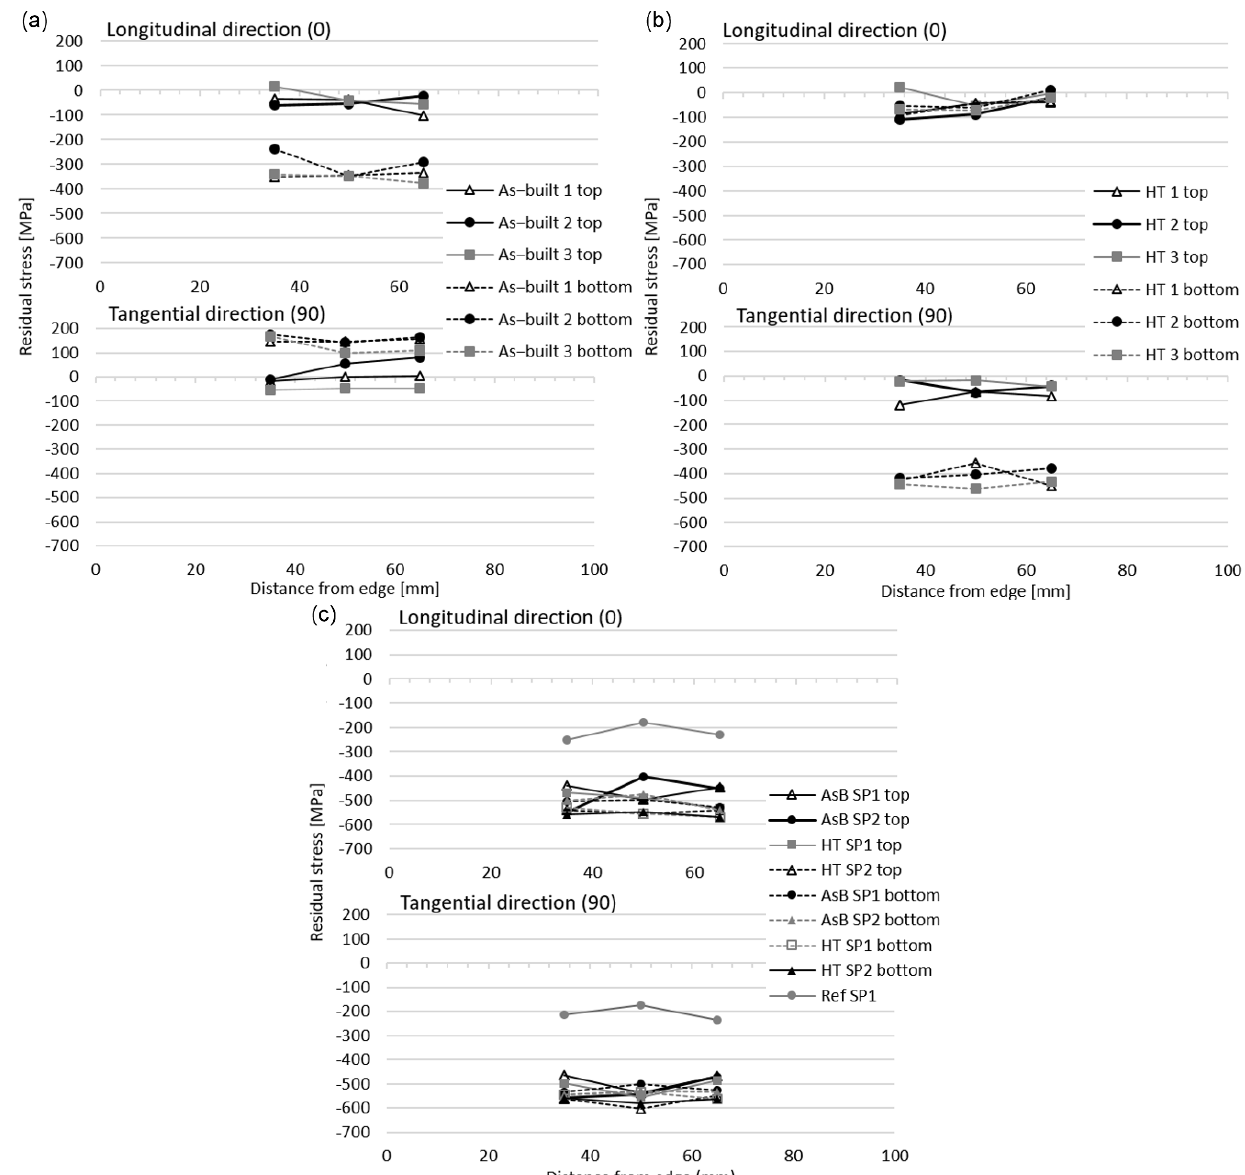
Figure 7. ( a ) Surface residual stresses of three AsB AM samples (top) and (bottom) surfaces in longitudinal and tangential directions. Typical deviation was 20–40 MPa. ( b ) Surface residual stresses of three stress relief annealed AM samples (top) and (bottom) surfaces in longitudinal and tangential directions. Typical deviation was 20–40 MPa. ( c ) Surface residual stresses of shot peened samples AsB, HT and Ref (top), and (bottom) surfaces in longitudinal and tangential directions.